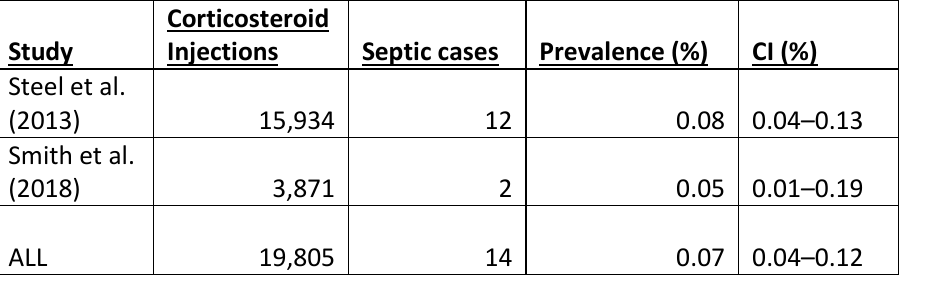
Table 2: Prevalence estimates for iatrogenic synovial sepsis following corticosteroid injections in the only two included studies which provided the necessary data (as calculated by the author of this Knowledge